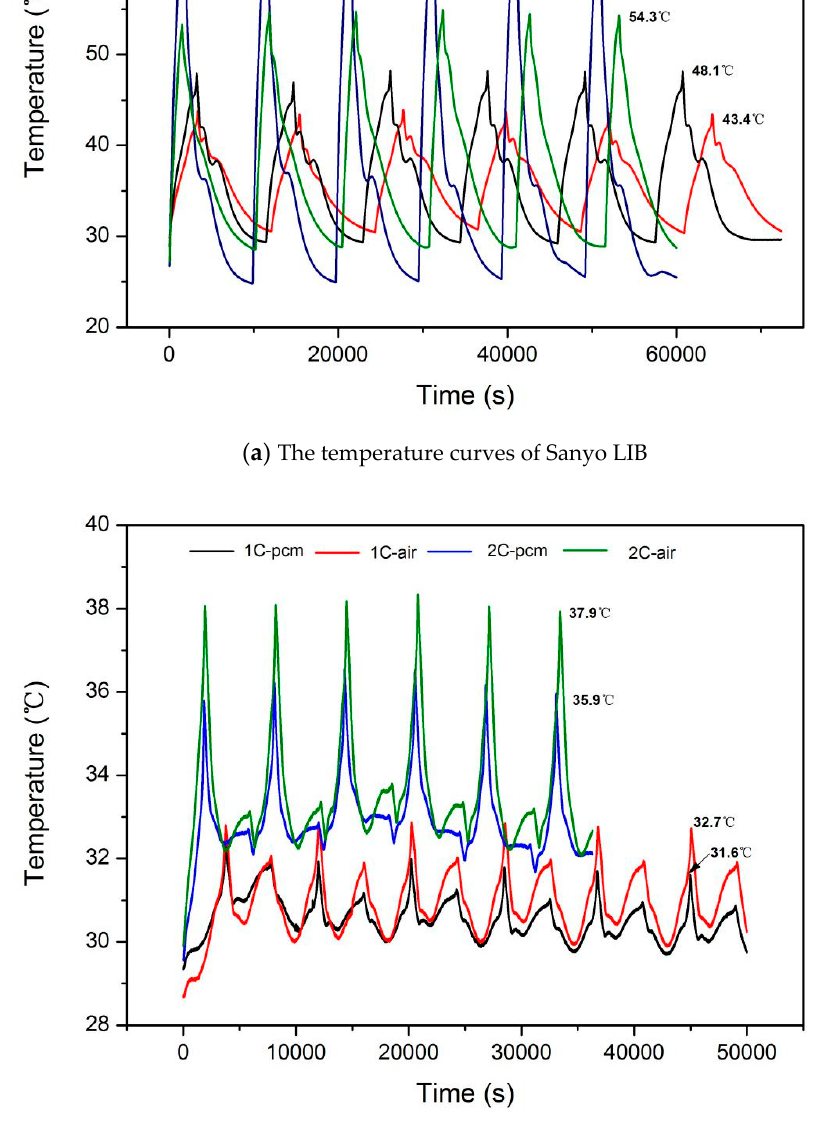
Figure 7. The temperature curves of Sanyo and Sony LIB under 1 C, 2 C discharging.